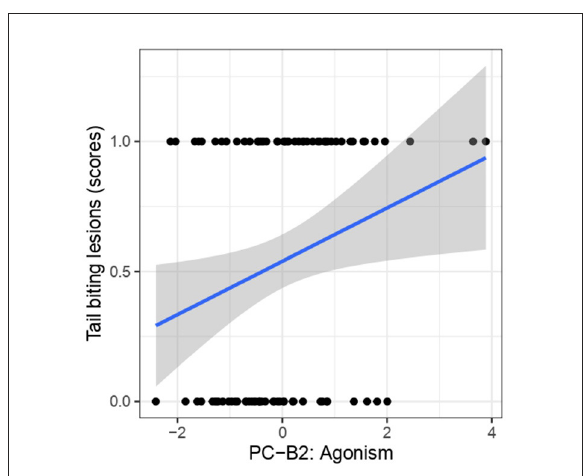
FIGURE4 The relationship betwen tail biting lesions scores and PC-B2 “Agonism.”